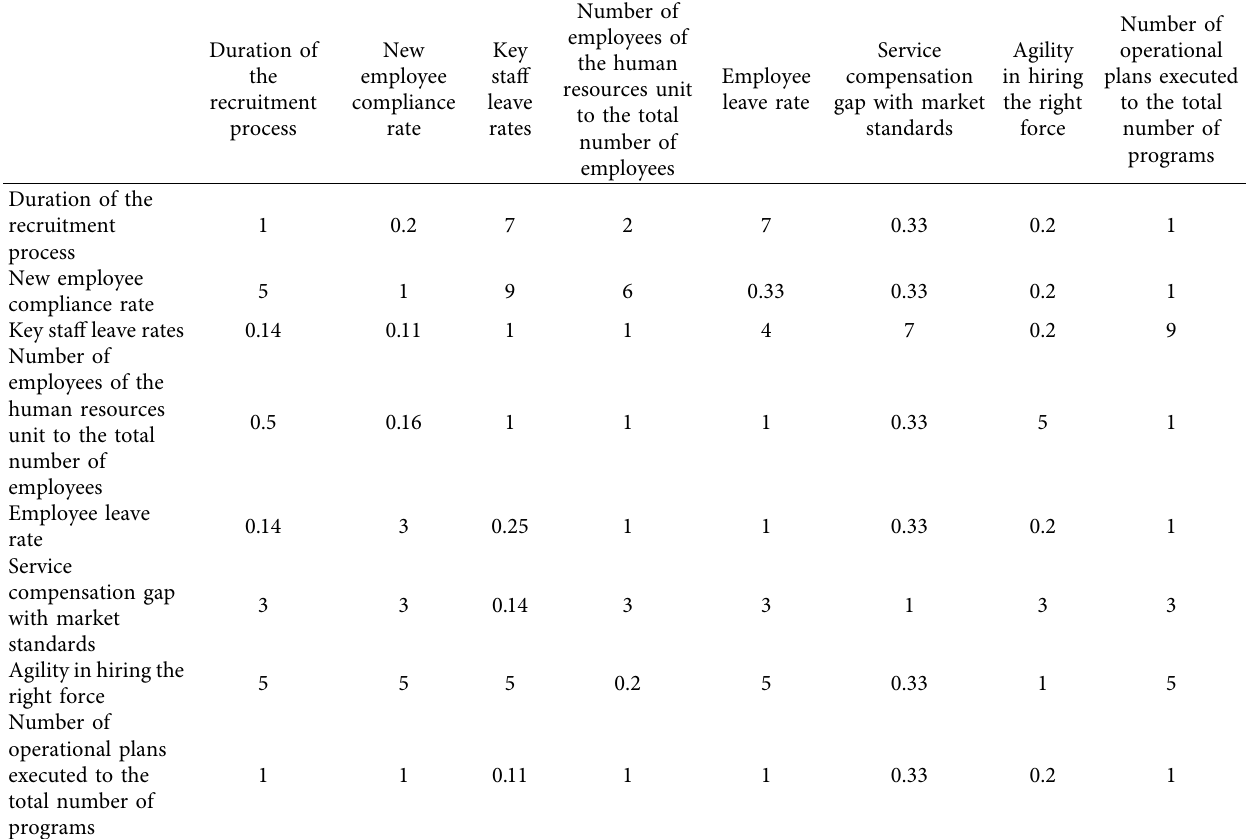
Table 8: Matrix of pairwise comparisons of criteria in terms of internal